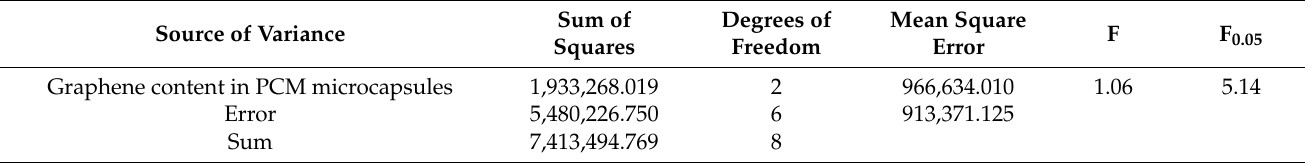
Table 15. Variance analysis of the bending strain energy in the performed wheel tracking test. Sum of Source of Variance